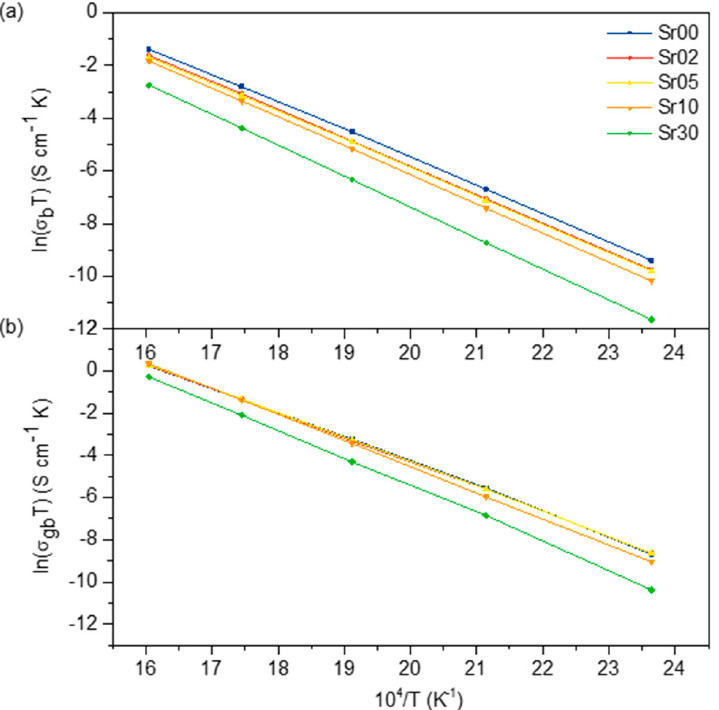
Figure 8. Arrhenius plots of ( a ) bulk and ( b ) grain boundary components of conductivity for the samples indicated.